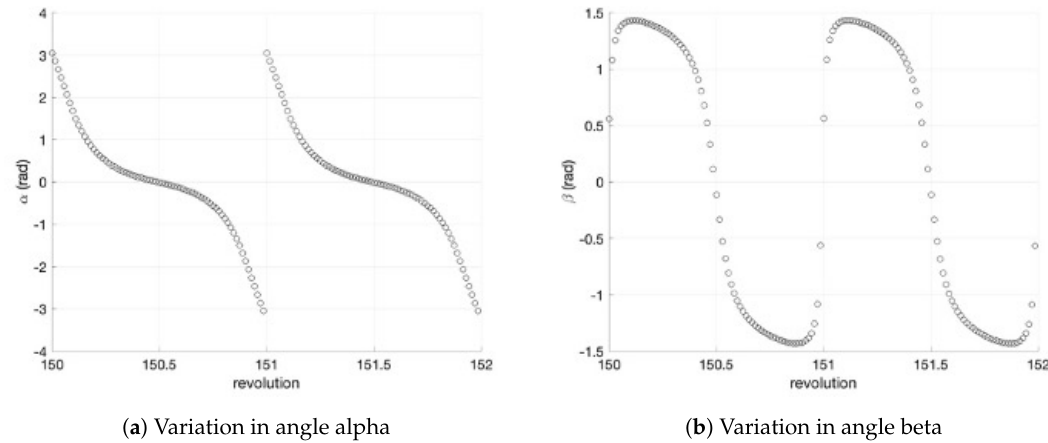
Figure 9. Variations of angles alpha and beta over two revolution during the